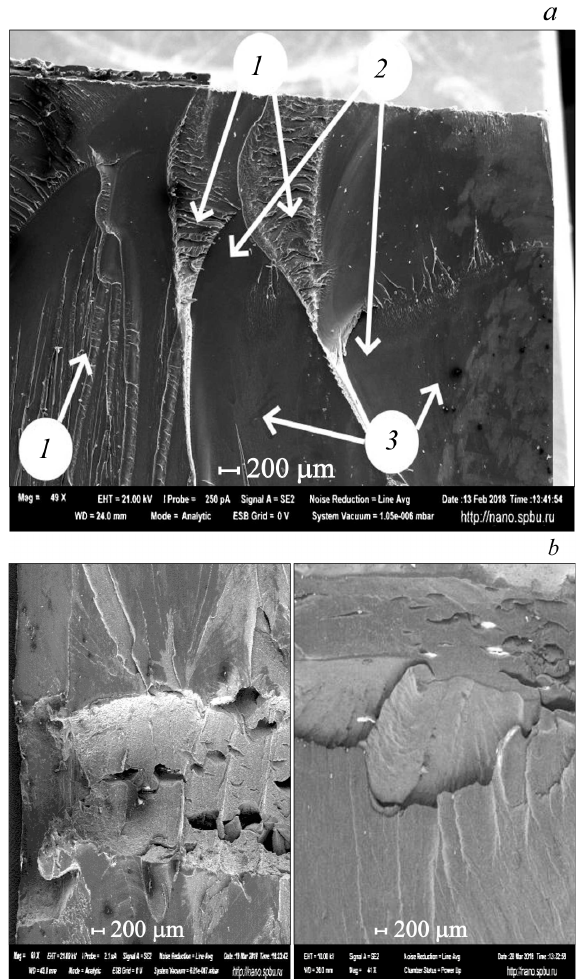
Figure 1. Structures formed on fracture surfaces of polymethylmethacrylate ( a ) and fluoroplastic ( b ) samples being rapidly fractured with electric explosion of wire [16]. Regions of increased roughness (1), mirror areas (2), and areas of geometric shapes (3) were identified for a polymethylmethacrylate sample ( a